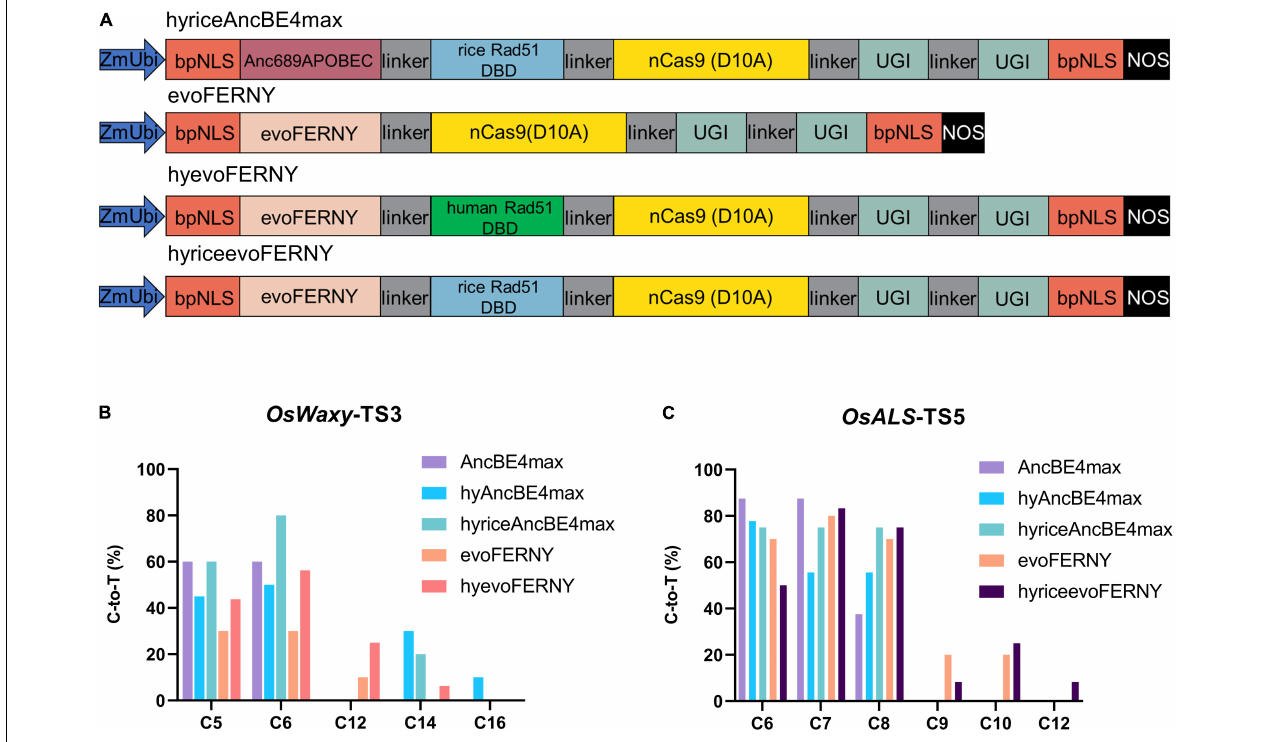
FIGURE 3 | Characterization of hyriceAncBE4max, evoFERNY, hyevoFERNY, and hyriceevoFERNY in rice. (A) Schematic structures of hyriceAncBE4max, evoFERNY, hyevoFERNY, and hyriceevoFERNY. Rice Rad51 DBD was synthesized and cloned into AncBE4max to form hyriceAncBE4max. The cytosine deaminase evoFERNY was synthesized using a plant optimized code and cloned replacing Anc689APOBEC in AncBE4max to generate evoFERNY. HyevoFERNY and hyriceevoFERNY were produced by introducing the human Rad51 DBD or rice Rad51 DBD with evoFERNY respectively. (B) C-to-T editing efficiency at different positions for OsWaxy -TS3 using different base editors. (C) C-to-T editing efficiency at different positions for OsALS -TS5 using different base